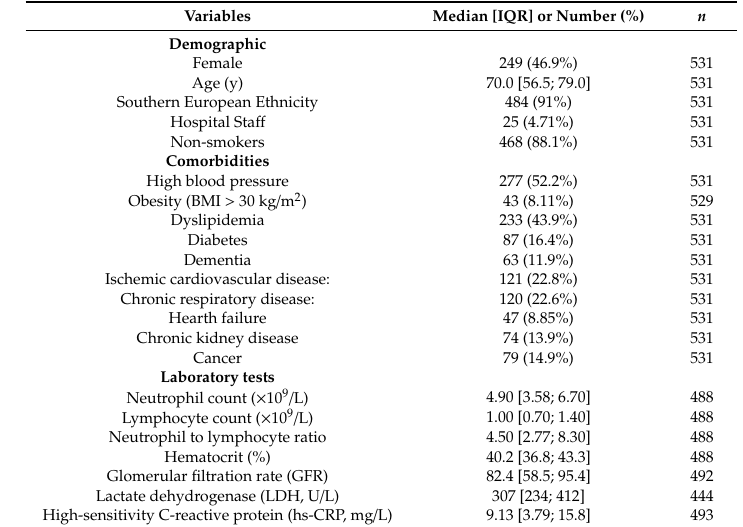
Table 1. Demographic characteristics, comorbidities, and laboratory tests at hospital